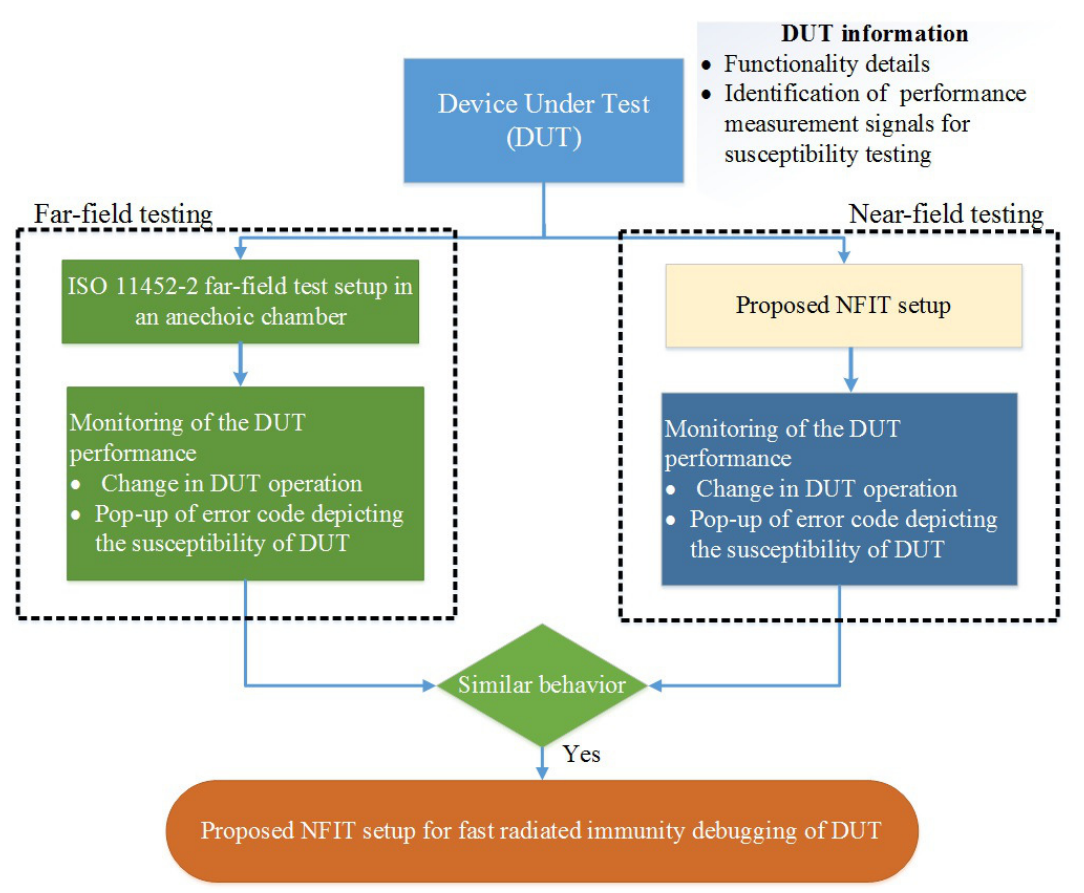
Figure 3. Flow chart used for the verification of the proposed NFIT